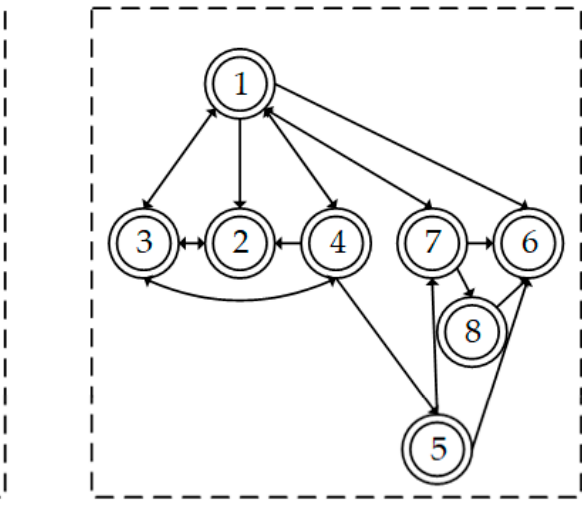
Figure 8. Division of two major urban agglomerations into cohesive subgroups.